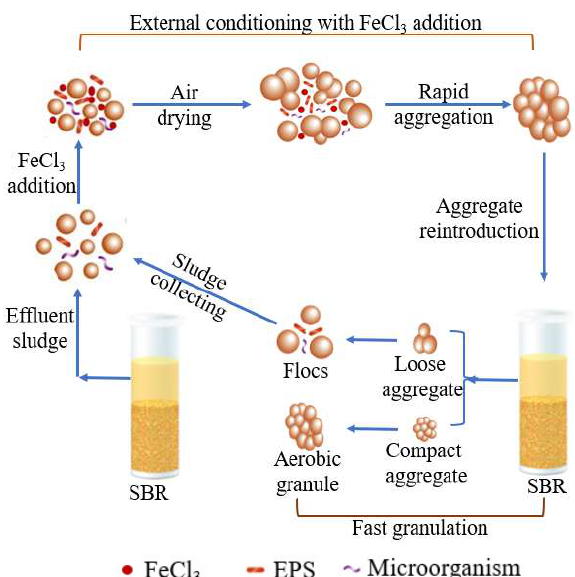
Figure 7. Proposed rapid granulation model using external conditioning with the FeCl 3 addition and the reintroduction of aggregates in an